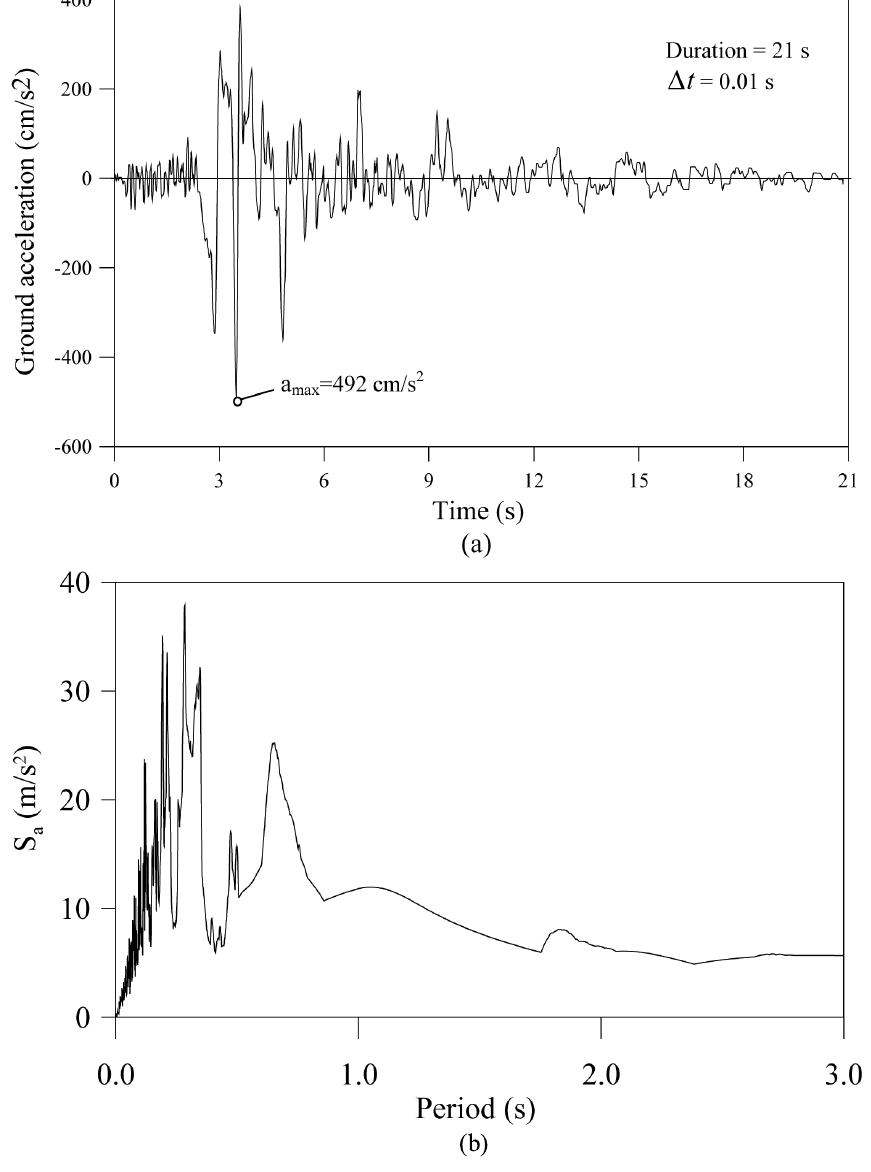
Fig. 3. (a) East-West component of the March 13, 1992 Erzincan earthquake in Turkey and (b) its acceleration